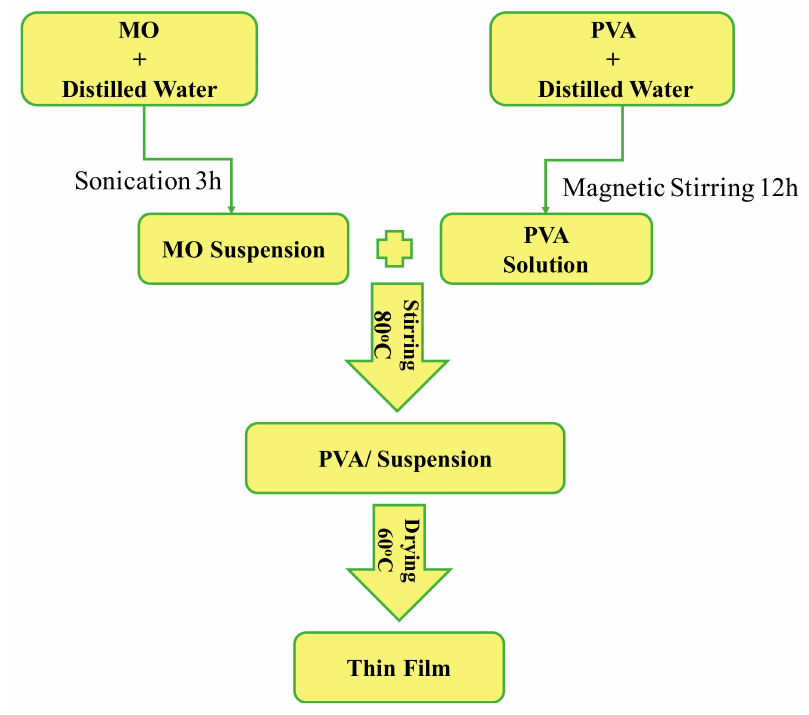
Figure 1. Schematic diagram for preparation of nanocomposite thin films. Table 1. List of samples with different amounts of nano-fillers in 10% PVA solution. Sr.